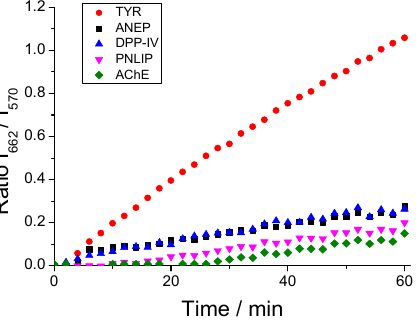
Figure 4. Ratiometric measurements of fluorescence signals of I 662 /I 570 of DCM-HBU (10 μ M) over time in the presence of different related enzymes at the same concentration (5 μ g mL − 1 ) by excitation at 450 nm at 37 °C.